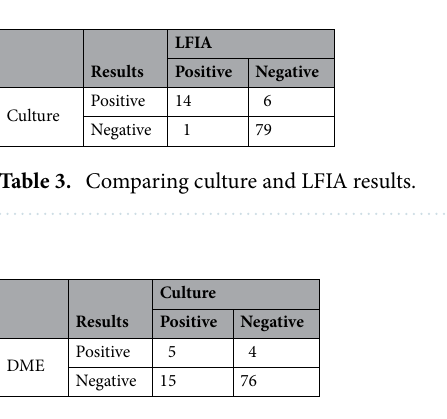
Table 4. Comparing microscopic slide and culture